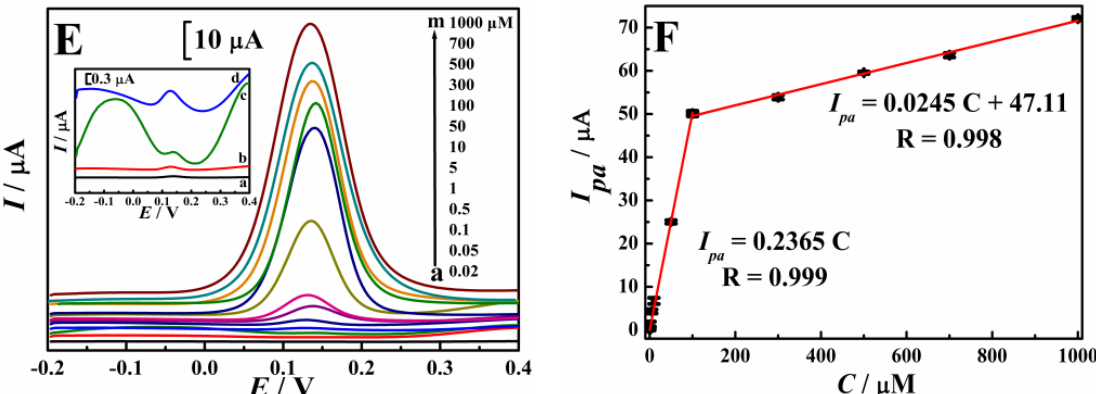
Figure 8. Effects of the volume ratio of Cu-TCPP to graphene ( A ), accumulation potential ( B ), accu- mulation time ( C ), and the amount of Cu-TCPP/graphene suspension ( D ) on the oxidation response of 1 µM DA, ( E ) DPV curves of DA on the Cu-TCPP/graphene/GCE with varying concentrations, and ( F ) calibration plots. Error bar represents the standard deviation of triple measurements.